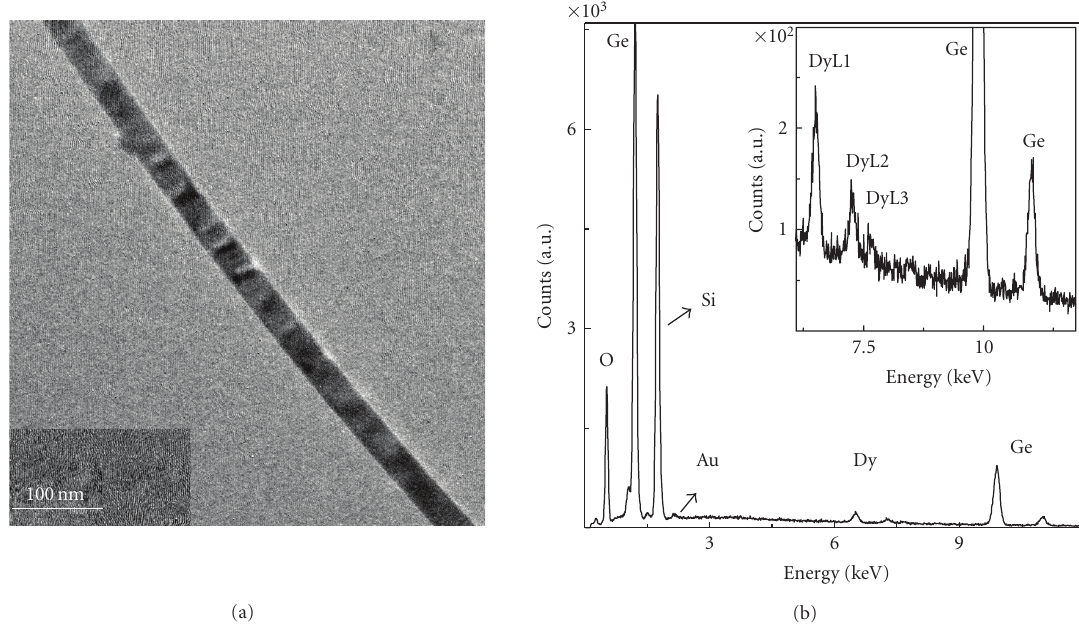
Figure 2: (a) A low-resolution TEM image of a Ge 98 Dy 2 nanowire. (b) EDX spectrum acquired with an SEM, supplied with a Sahara II Silicon drift detector. In the inset is displayed the magnified part of the spectrum between 6 keV and 12keV with DyL1, DyL2, DyL3, and